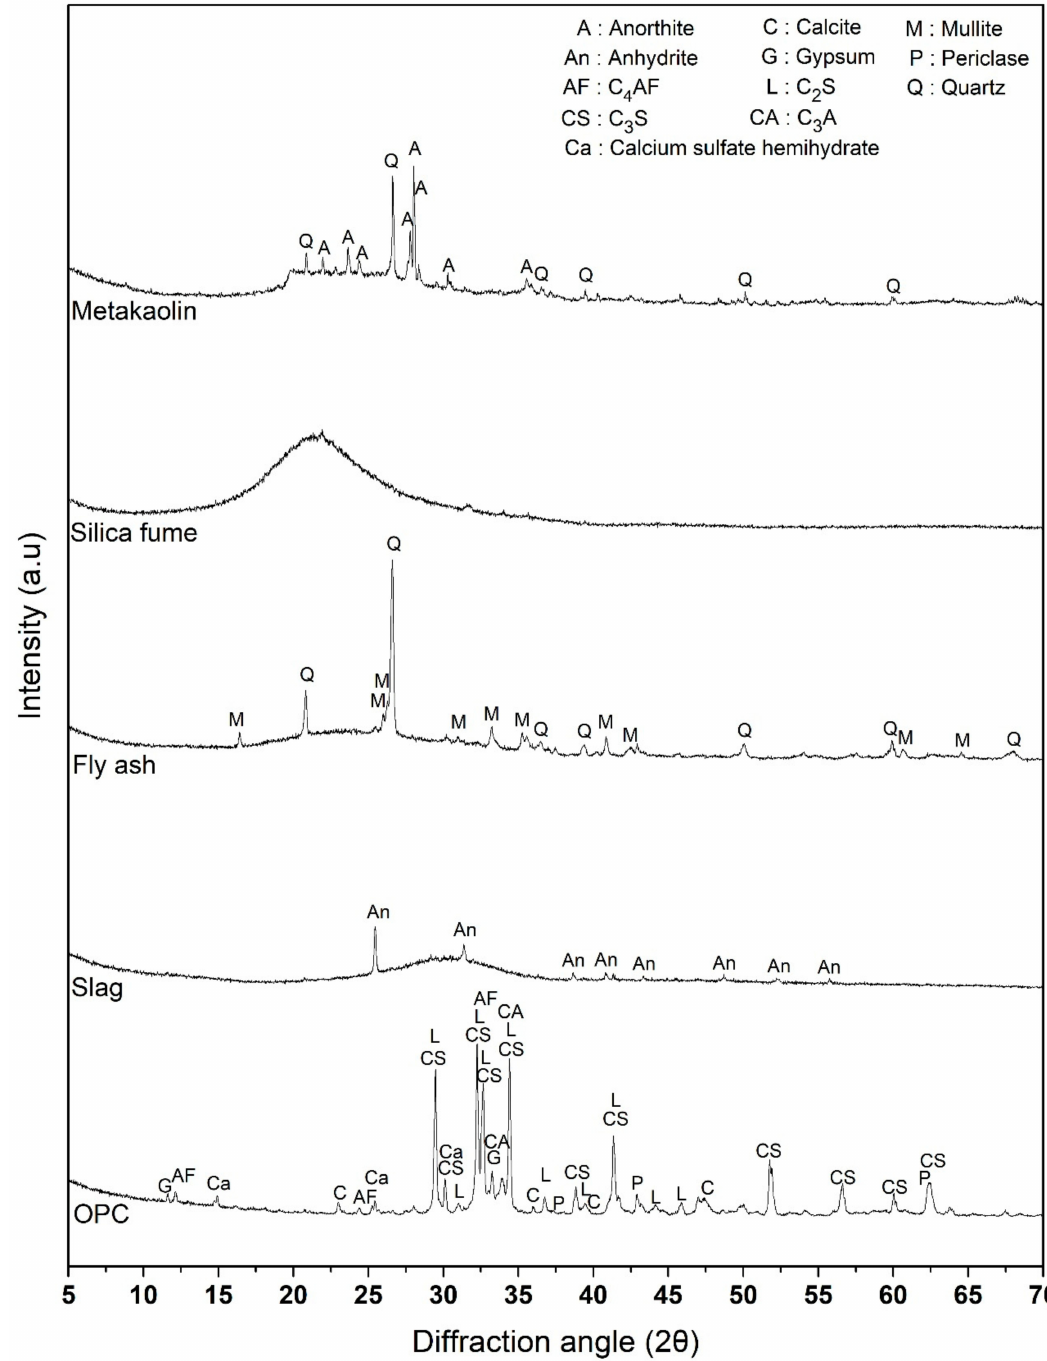
Figure 1. XRD patterns of cementitious materials used for the